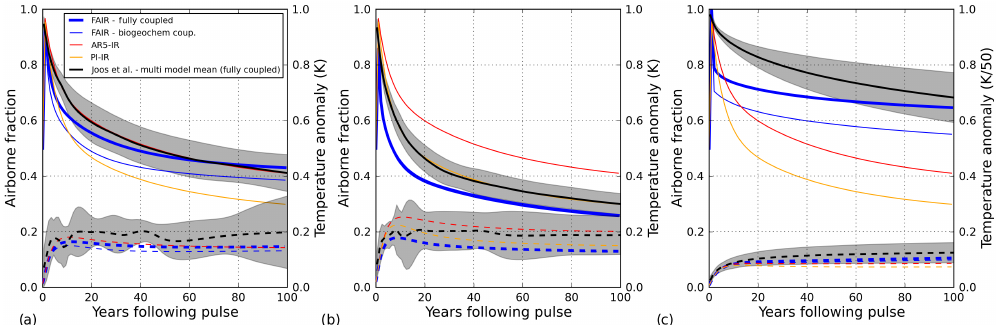
Figure 3. Response to pulse emission experiments of Joos et al. (2013). (a) shows the response to a 100GtC imposed on present-day (389ppm) background conditions (PD100 experiment), (b) the response to a 100GtC pulse in preindustrial conditions (PI100 experiment) and (c) the response to a 5000GtC pulse in preindustrial conditions (PI5000 experiment) with the warming normalised by the increase in pulse size between (b) and (c) . Airborne fraction (left-hand axis) is represented by solid lines in all panels and warming (right-hand axis) by dashed lines. FAIR is shown as thick blue lines, AR5-IR as red, and PI-IR as orange. The black lines in all panels shows the Joos et al. (2013) multi-model mean for airborne fraction (solid) and warming (dashed), with the grey shading indicating 1 standard deviation uncertainty across the ensemble. Thin blue lines denote the biogeochemically coupled version of